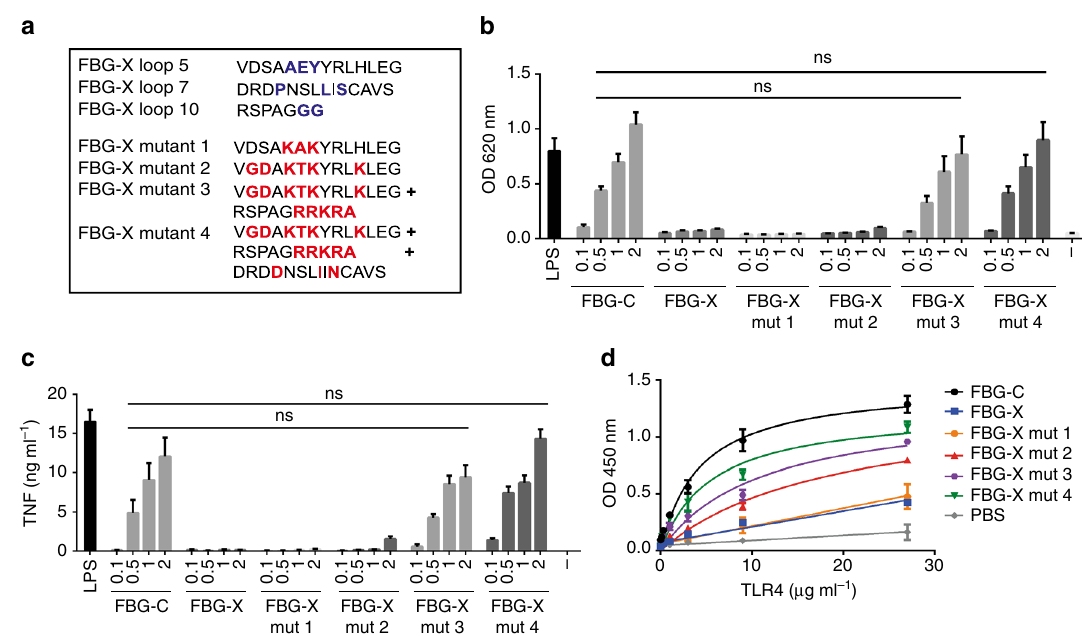
Fig. 5 Mutations in FBG-X confer TLR4-activating ability. a FBG-X chimeric proteins were designed to introduce the amino acids found in FBG-C to activate and bind to TLR4 (red) into the FBG-X sequence (blue). b ThP1 NF-kB cells were left unstimulated ( − ) or stimulated for 24h with 0.5ngml − 1 of LPS or increasing doses ( μ M) of FBG-C, FBG-X, FBG-X mutant 1, 2, 3, and 4. NF-kB activation was measured using QUANTI-Blue ™ . Data shown as mean ± SEM. n = 3 independent experiments. One-way ANOVA vs. FBG-C. c Primary human macrophages were left unstimulated ( − ) or stimulated for 24h with 1ngml − 1 of LPS or increasing doses ( μ M) of FBG-C, FBG-X, FBG-X mutant 1, 2, 3, and 4. Cytokine synthesis was measured by ELISA. Data shown as mean+SEM. n = 3 independent donors. One-way ANOVA vs. FBG-C. d 96-well plates were coated with 1 µ gml − 1 of FBG-C, FBG-X, FBG-X mutant 1, 2, 3, and 4, and TLR4 was added in a dose-dependent manner. Data shown as mean ± SEM. n = 4 independent FBG domains (Supplementary Fig. 6b). Comparison of the